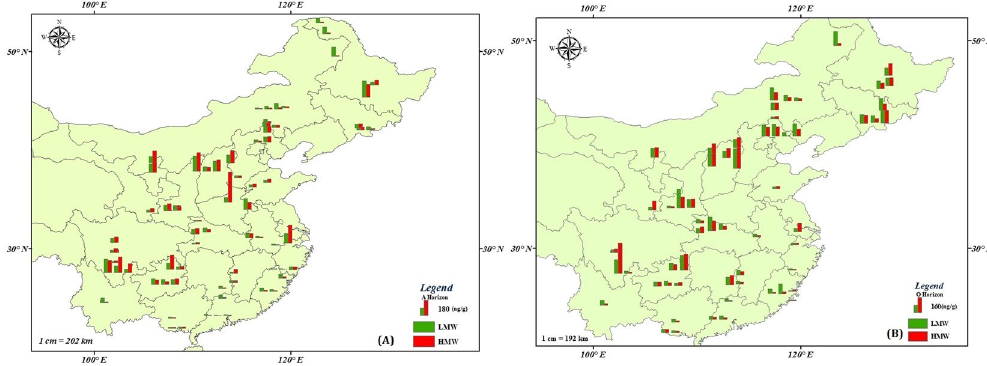
Figure 2. Geographical distribution of LMW- & HMW-PAHs across Chinese forest soils ( A ) A-horizon and ( B ) O-horizons. (The background map was made using ArcGIS 9.3 by one